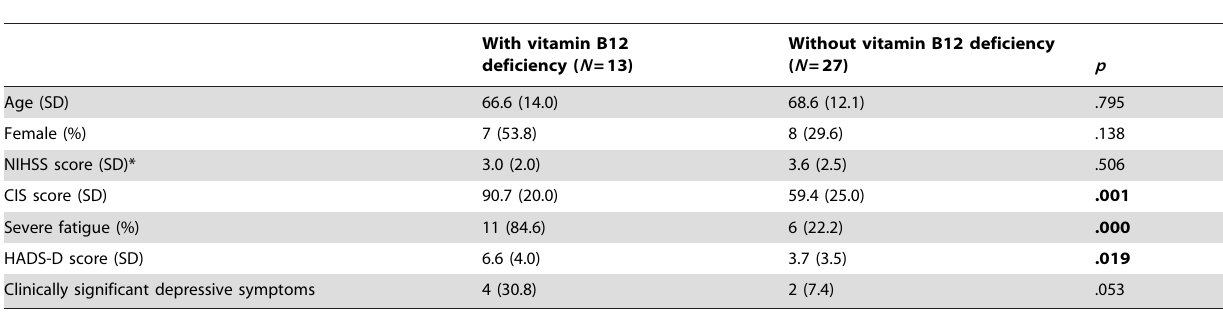
Table 1. Demographics and mean scores for lacunar stroke patients with and without vitamin B12 deficiency.